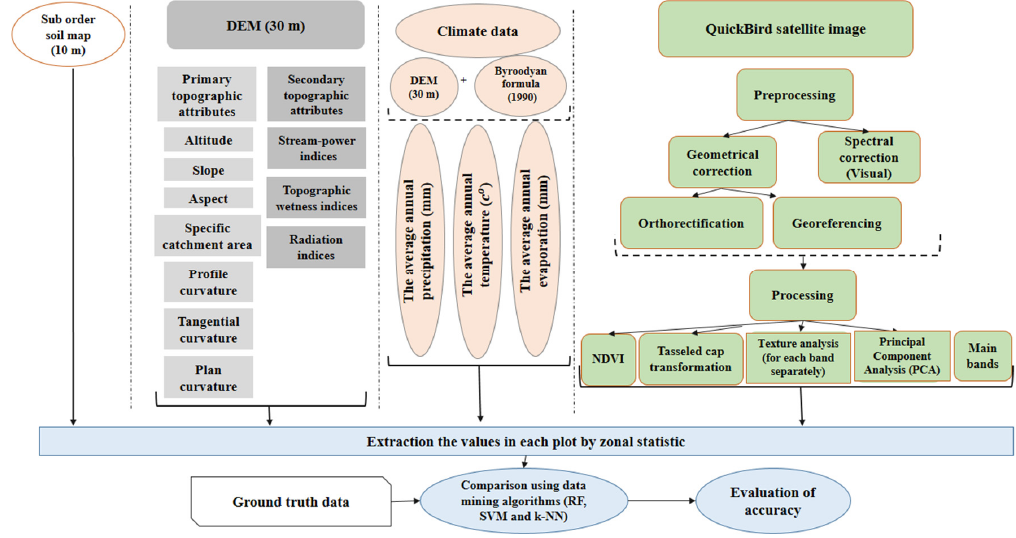
Figure 4. Data processing workflow illustrates the structure and order of layer preparation and different categories of layers which are used in our